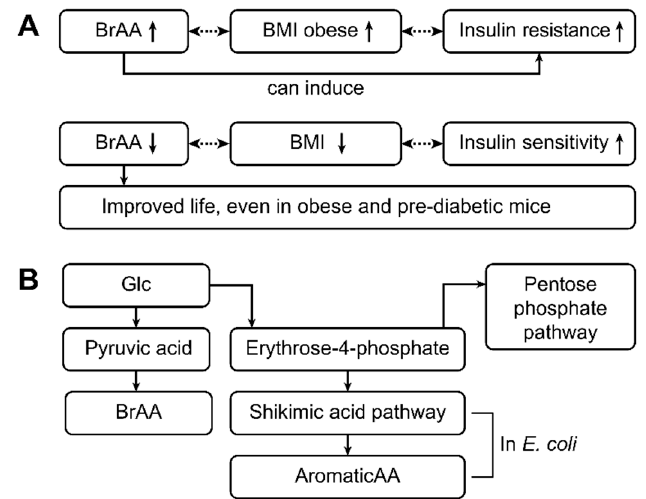
Figure 5. This figure shows the pathophysiology and pathways related to the metabolic changes that occur in patients with type 1 and type 2 diabetes. High levels of branched-chain amino acids (BRAAs) are often associated with increased BMI levels (obesity) and insulin resistance (type 2 diabetes) [23–25]. In contrast, low levels of BRAAs are accompanied by lower BMIs and good insulin sensitivity. Thus, BRAAs appear to induce insulin resistance. Decreasing the BRAA concentration might improve life, as has been shown in obese and prediabetic mice [73]. BRAAs are synthesized from glucose via pyruvic acid. Glucose is normally used in the pentose phosphate pathway, and erythrose-4-phosphate is obtained as an intermediate product. In contrast, erythrose-4-phosphate is an important educt of the shikimic acid pathway, which is an important pathway in enteral E. coli . As a result, aromatic amino acids are produced by E. coli from erythrose-4-phosphate [11,32,72] and from glucose in patients with type 2 diabetes mellitus and high glucose concentrations [72].